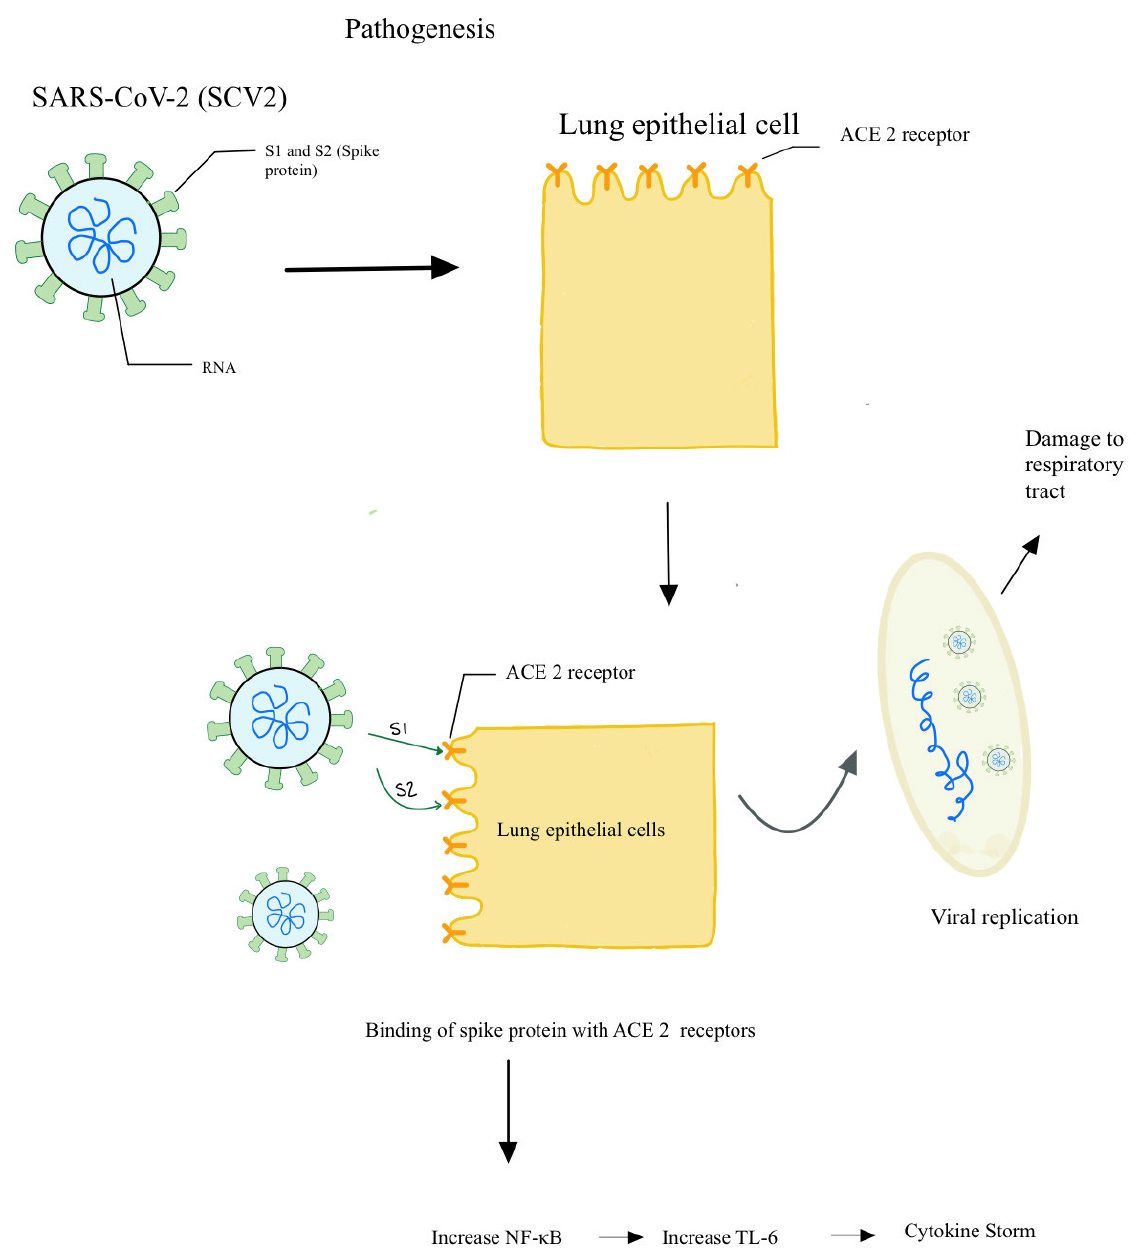
Figure 1. Schematic model explaining the pathogenesis in